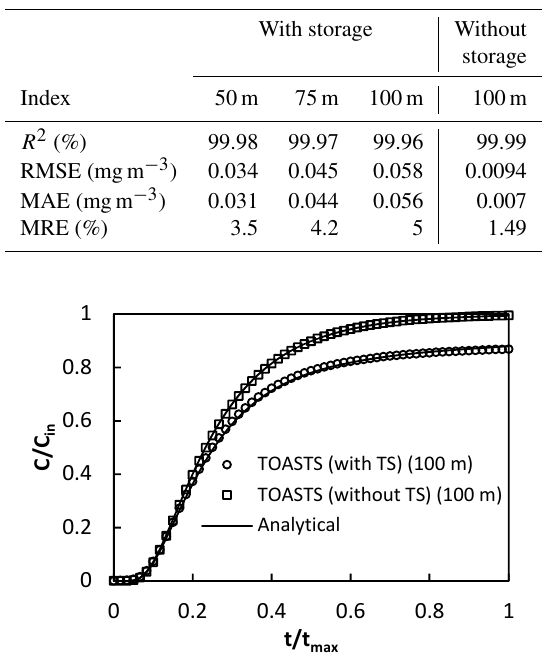
Figure 2. Results of the TOASTS model verification by the analyt- ical solution for continuous boundary condition ( α = 0).